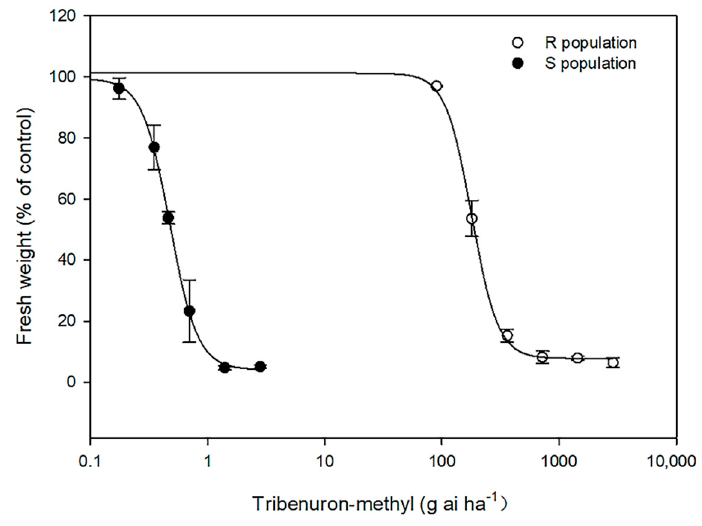
Figure 1. Dose-response curve for the R( ○ ) and S( ● ) populations treated with different concentrations of tribenuron-methyl. Each point represents the mean of two experiments, each containing three replicates, and error bars represent the standard error. The fresh weight reduction rate is presented as a percentage of that recorded from the untreated plants.